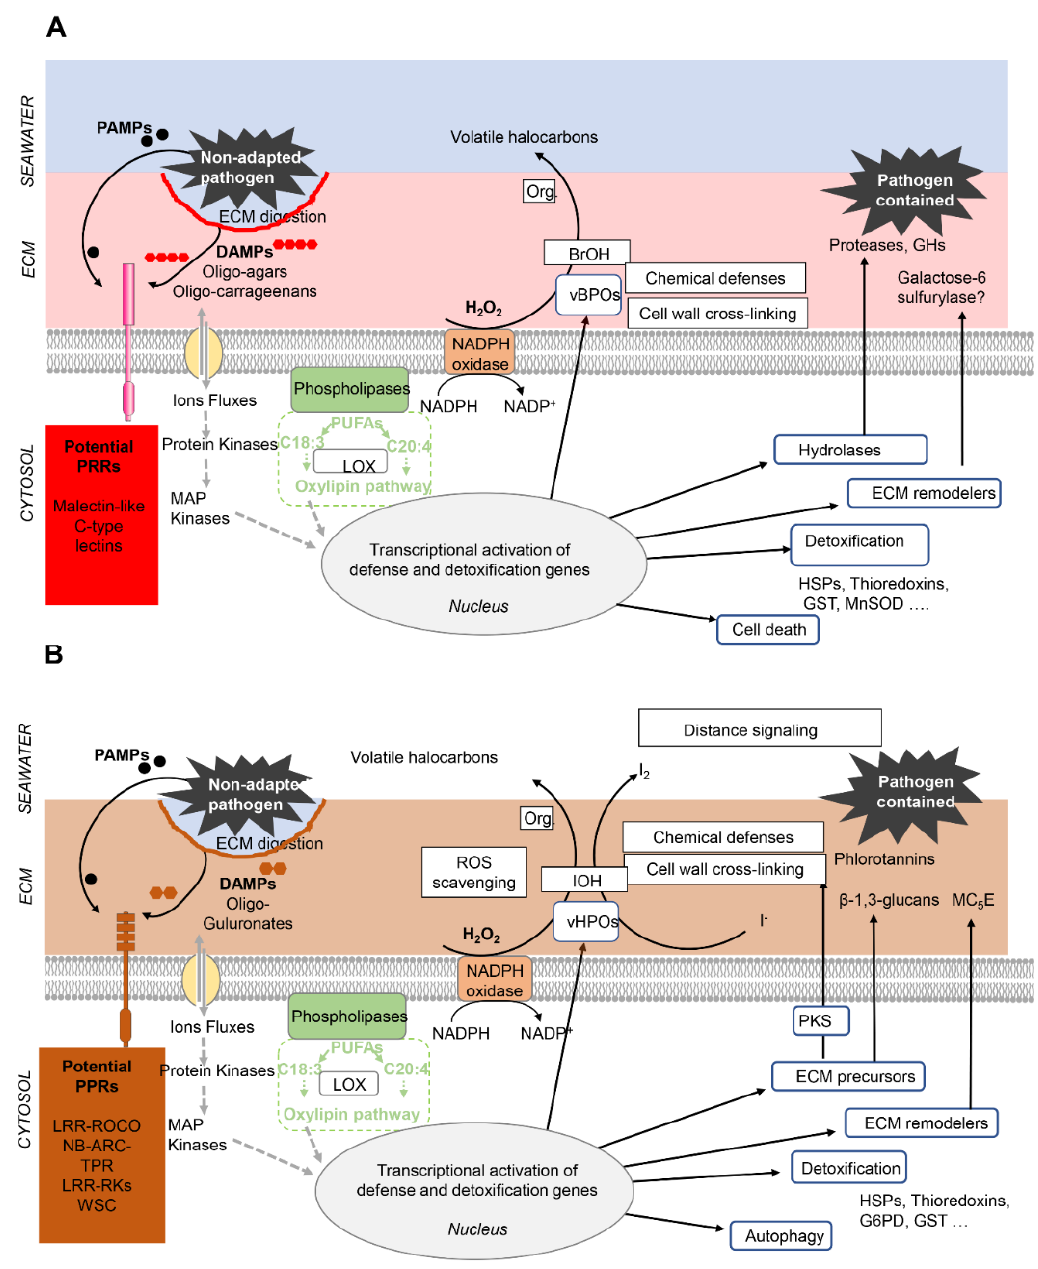
Figure 7. Role of the extracellular matrix in the innate immunity of multicellular red (A) and brown (B) algae. Drawings adapted from in [136] and updated based on evidence provided by the authors of [7,139,140,149,152,161]. Note that the basic principles of innate immunity are shared by brown and red algae (as well as by plants and animals): recognition by Pattern Recognition Receptors (PPRs) of pathogen-derived PAMPs or cell-wall derived DAMPs triggers signaling cas- cades that activate defense and detoxification responses. Red (A) and brown algae (B) differ by the nature of their DAMPs and PPRs, highlighted in red and brown, respectively. In the ECM per se the main defense responses deal with ECM remodeling (thickening, strengthening) and the secretion of chemicals and enzymes that target the pathogen, eventually leading to the containment of non-adapted pathogens. Abbreviations: PAMPs, pathogen associated molecular patterns; DAMPs, Damage associated molecular patterns; PUFAs, poly unsaturated fatty acids; MAP Kinase, mitogen activated protein kinase; LOX, lipoxygenase; vHPO, vanadium-dependent haloperoxidase; IoH, hypoiodous acid; vBPO, vana- dium-dependent bromoperoxidase; BrOH, hypobromous acid; ROS, reactive oxygen species. Org. organic compound. HSPs, heat shock proteins; G6PD, glucose-6-phospate-dehydrogenase; GST, Glutathion-S-transferase; SOD, superoxide dismutase; PKS, polyketate synthase; MC5E, mannuronan C5 epimerase, GHs, glycoside hydrolases. The striking similarity between animal NLRs and plant R-proteins raised the ques- tion of whether innate immune signaling systems are ancestral to all eukaryotes [127,129]. It is now agreed that, even though individual components of the plant and animal innate immune signaling pathways share some common protein motifs, including TIR, NBS, and LRR domains, these motifs have been recruited independently in animals and plants [127,162,163]. Analysis of brown and red algal genomes support the view that the innate immunity systems also evolved independently in these lineages. The E. siliculosus genome